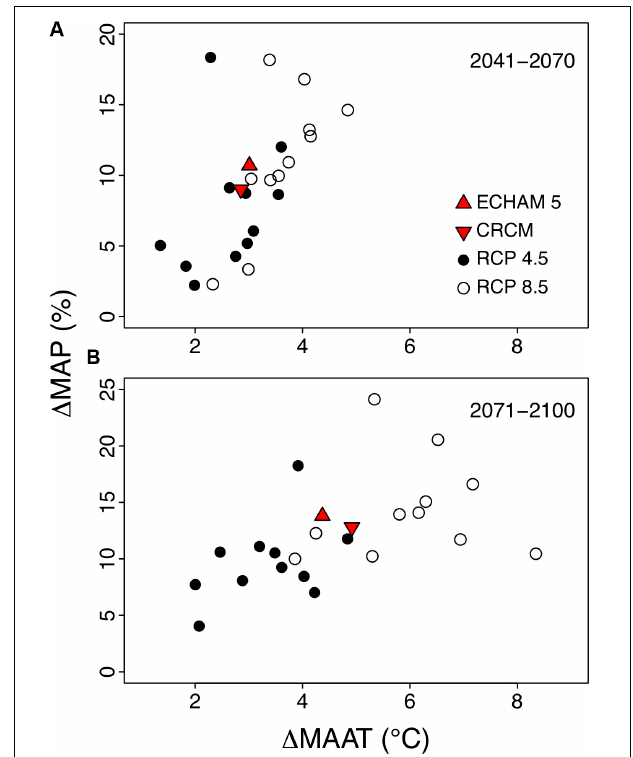
FIGURE 3 | Relative changes in mean annual precipitation (MAP) and mean annual air temperature (MAAT) for the study region as projected by 11 models under two GHG emission scenarios (RCP 4.5 and RCP 8.5) for the periods 2041–2070 (A) and 2071–2100 (B) . Projected changes by the climate models used in this study for coupled simulations (ECHAM 5 and CRCM) are also shown on the graphs. The 11 reference models are: ACCESS1.3, BNU-ESM, CMCC-CMS, CanESM2, GFDL-ESM2M, HadGEM2, INM-CM4, IPSL-CM5A-LR, IPSL-CM5B-LR, MPIESM-LR, and